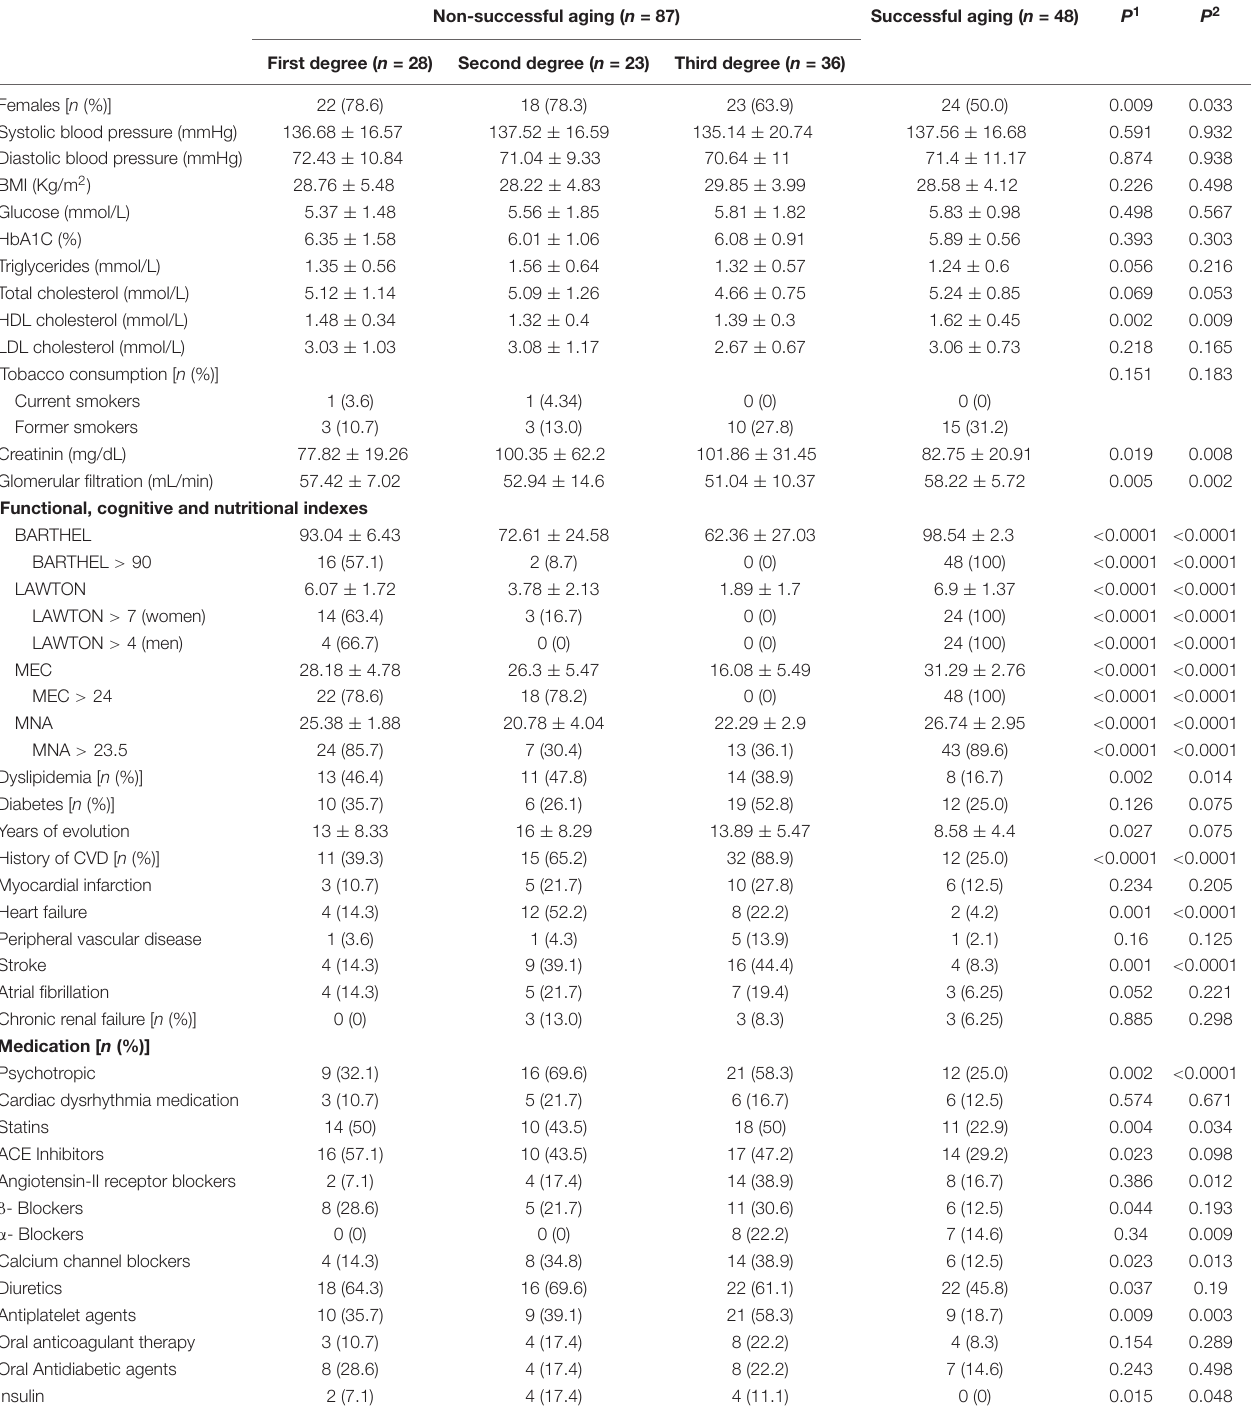
TABLE 1 | Characteristics of the 85-year old subjects included in the study according to successful aging. Non-successful aging ( n = 87) Successful aging ( n =